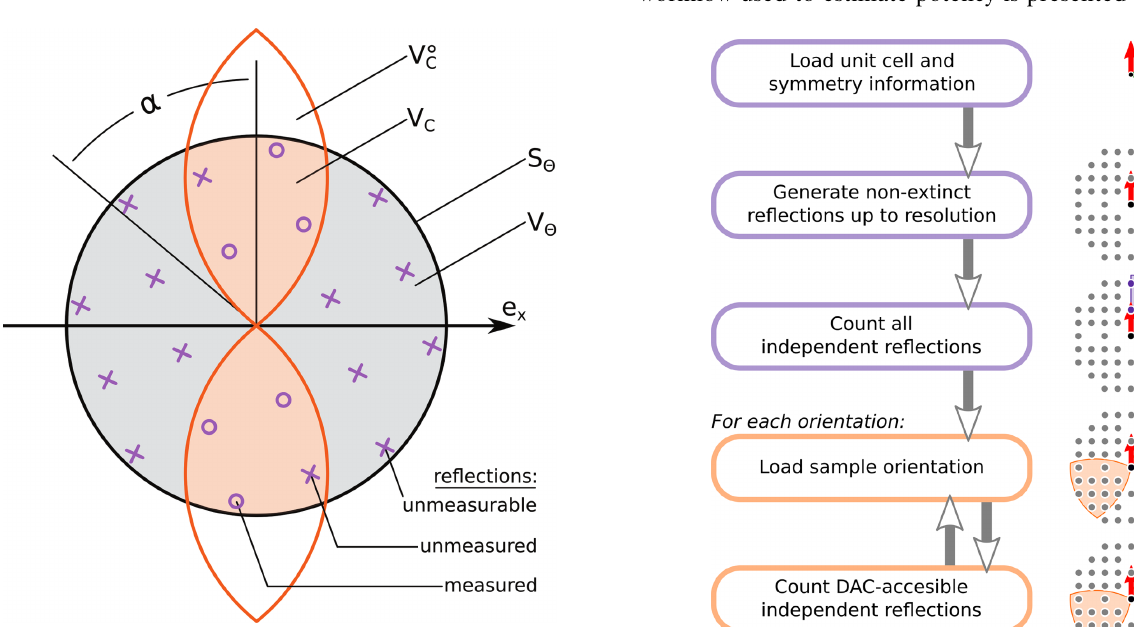
Figure 1 Total reciprocal space available to the pressure cell V (cid:2) angle (cid:2) , limited by investigated resolution sphere S (cid:2) down to V C . Assuming all reflections are symmetry-independent, the hypothetical experiment measured 6 out of 8 measurable and 20 total reflections, resulting in a C and c C of 75 and 30%, respectively. P of this setup, assuming ‘orange’ orientation of the sample, is 40%.